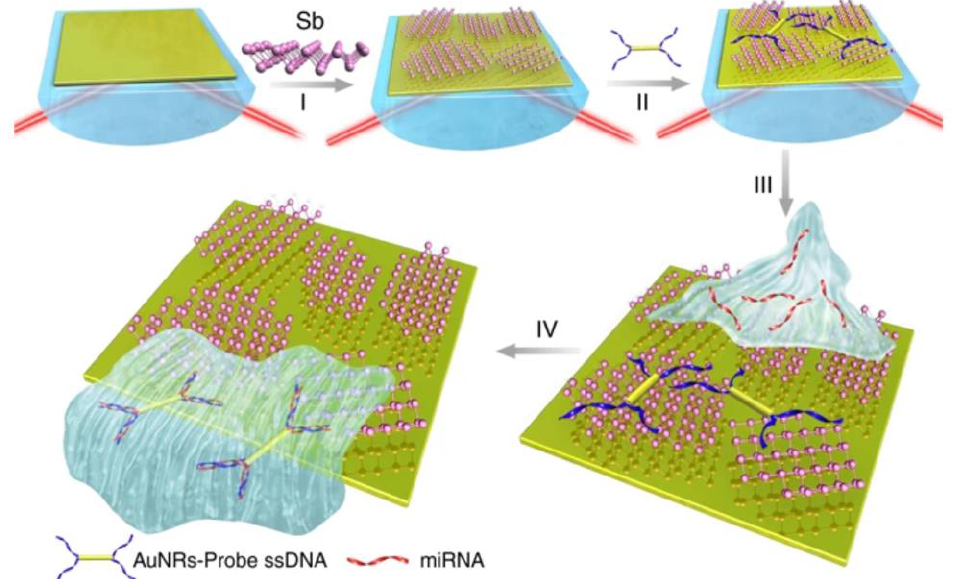
Figure 6. Fabrication of the microRNA sensor integrated with antimonene nanomaterials. (I) The antimonene nanosheets casted on Au substrate. (II) AuNR-ssDNAs adsorption. (III) miRNA binds to complementary AuNR-ssDNA to form a double-strand with complementary AuNR-ssDNA. (IV) AuNR-ssDNA released from the antimonene nanosheets. Reproduced with permission from [44]. Copyright Springer Nature, 2019.